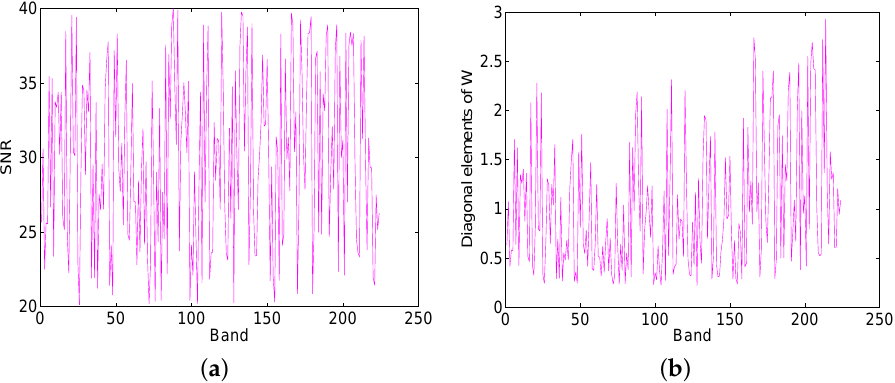
Figure 13. ( a ) The SNR of different band of the generated HSI and ( b ) diagonal elements of the weighting matrix using proposed SU-NLE in simulated experiment